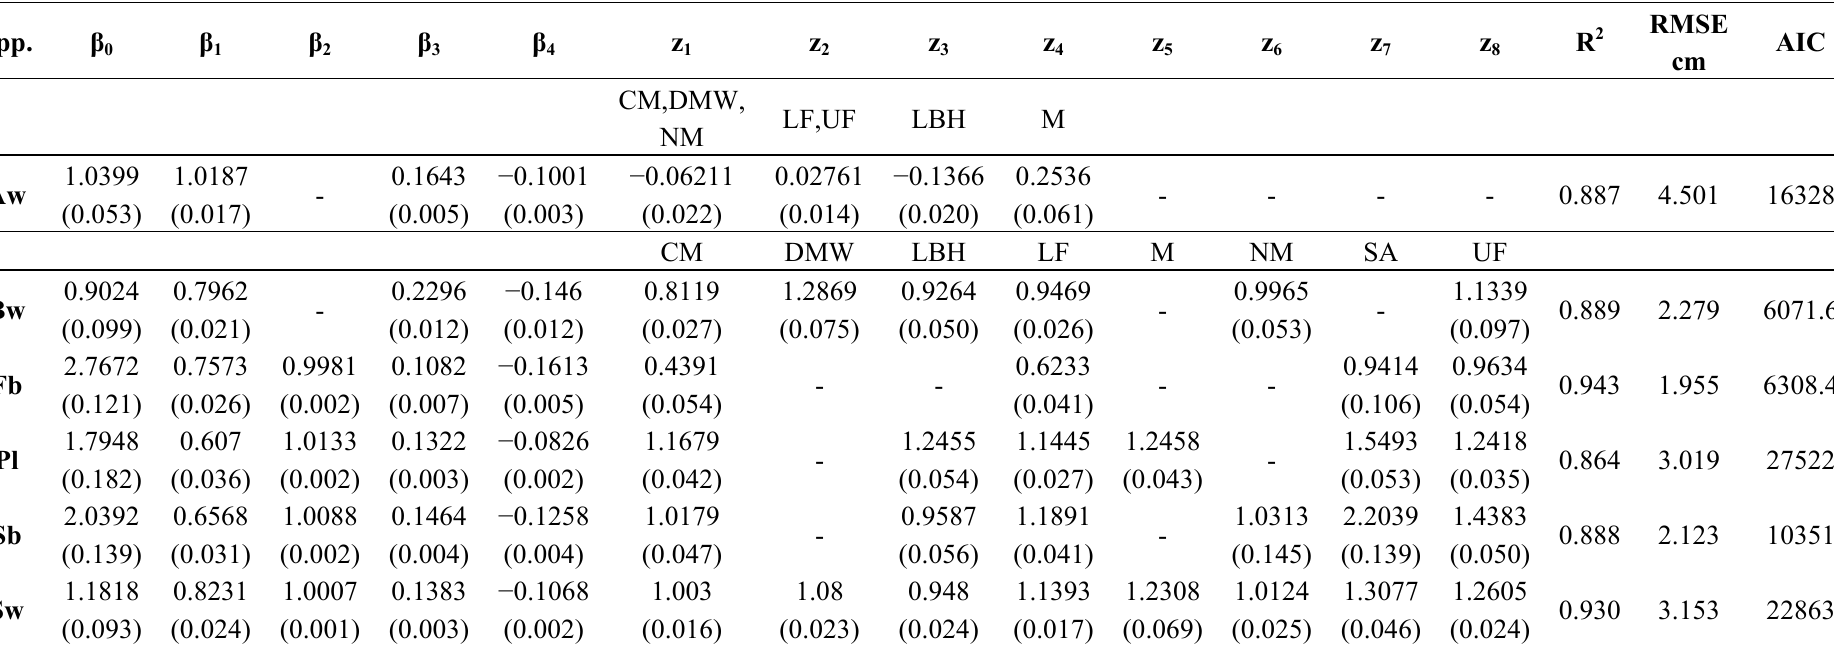
CM = Central Mixedwood; DMW = Dry Mixedwood; LBH = Lower Boreal Highlands; LF = Lower Foothills; M = Montane; NM = Northern Mixedwood; SA = Subalpine; UF = Upper